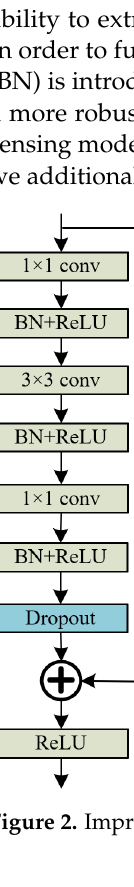
( b ) Figure 3. Comparison of the standard network and dropout network: ( a ) standard network; ( b ) dropout network with dropout rate of 0.5. The feed-forward operation of a standard neural network is represented as follows: ( 1)